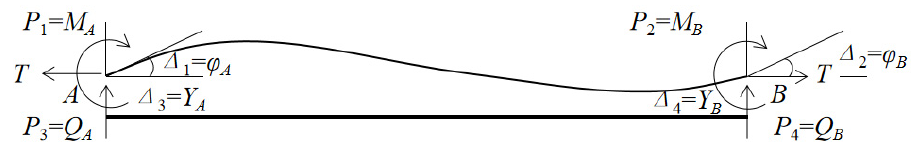
Figure 7. Cable vibration analysis unit.